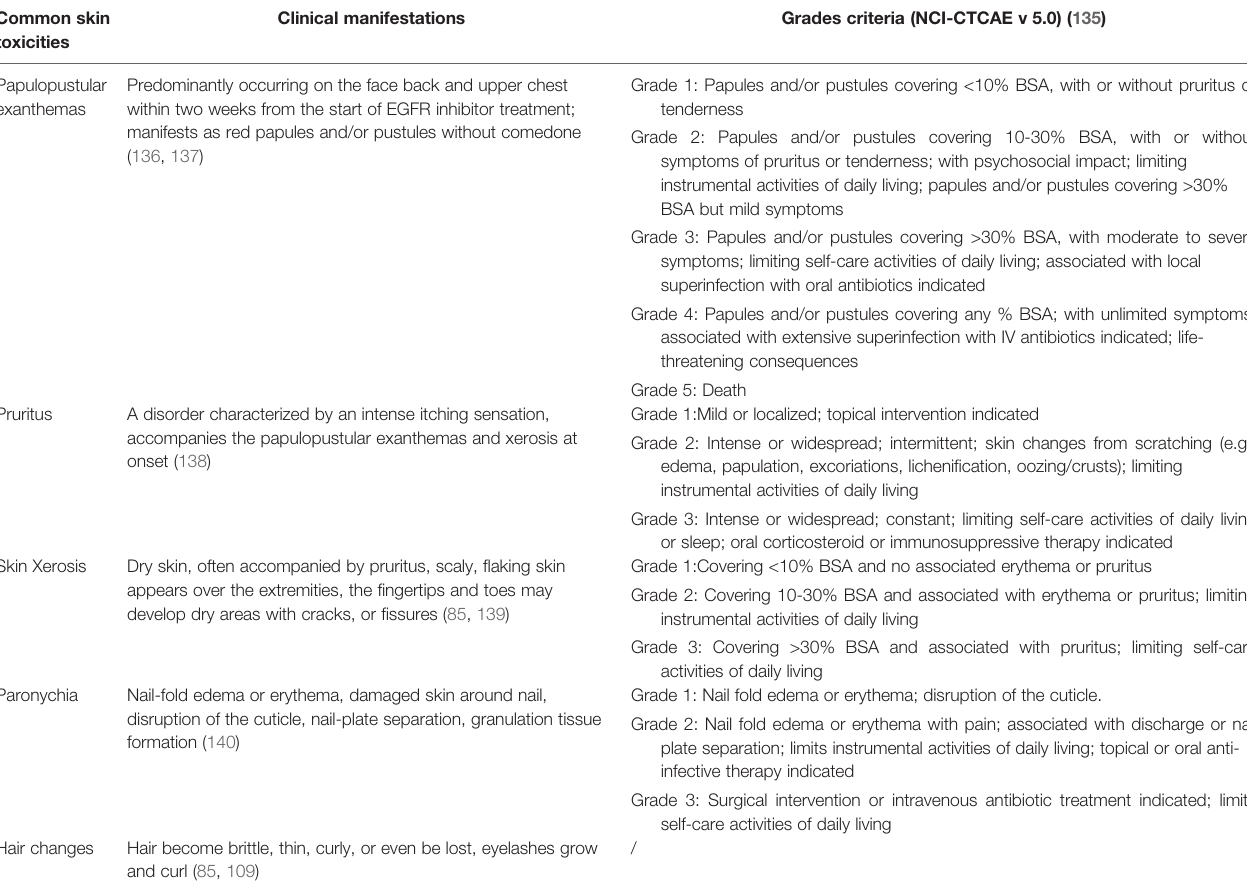
Clinical manifestations